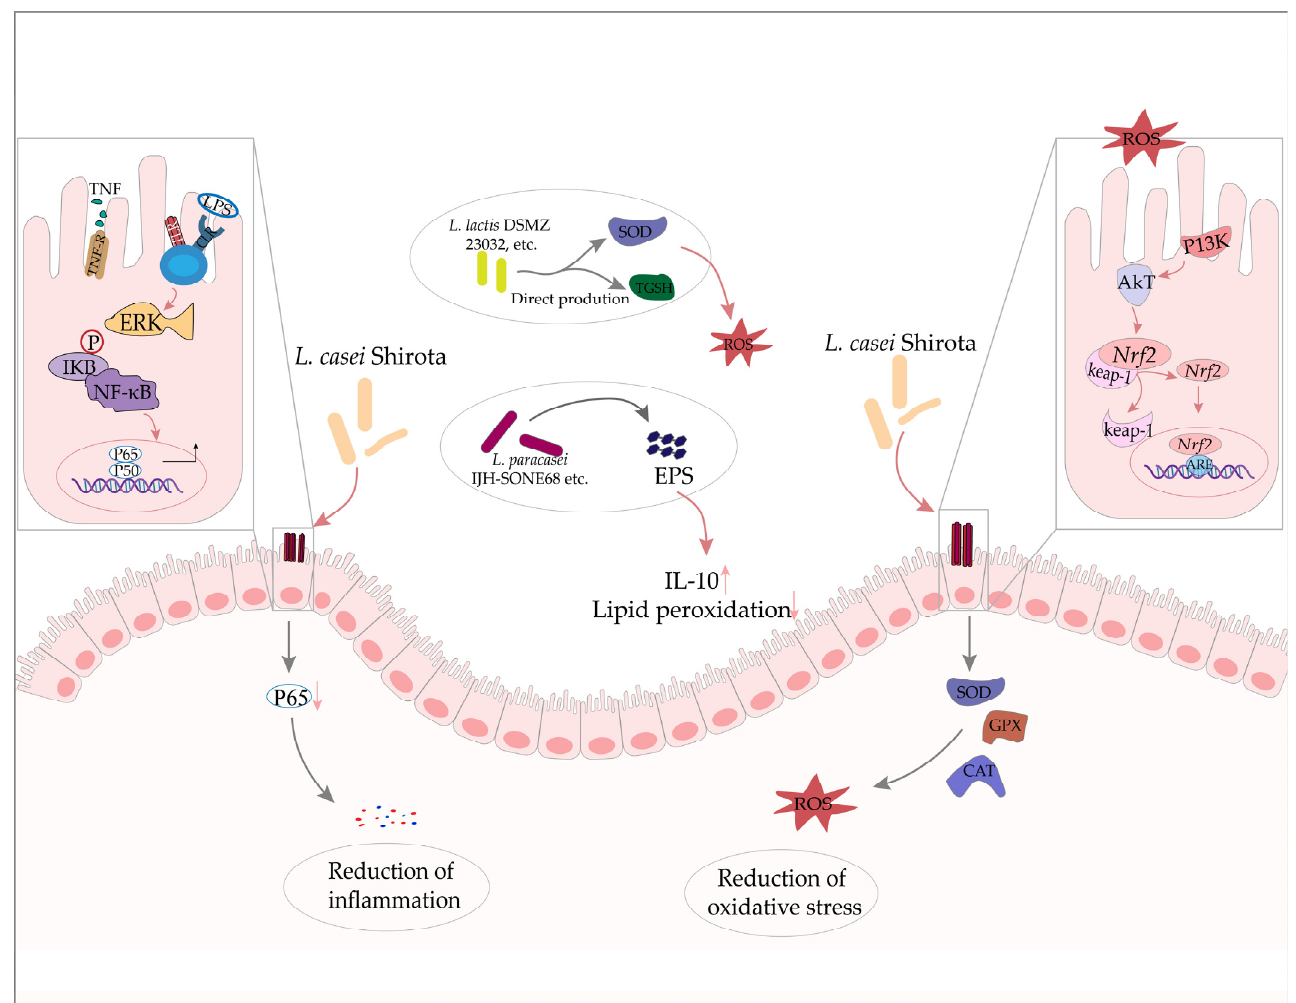
Figure 1. The role of Lactobacillus in IBD. Lactobacillus can produce EPS or/and related antioxidant enzymes to alleviate intestinal inflammation and oxidative stress, and ameliorate IBD by regulating the NF- κ B, Nrf2 signaling